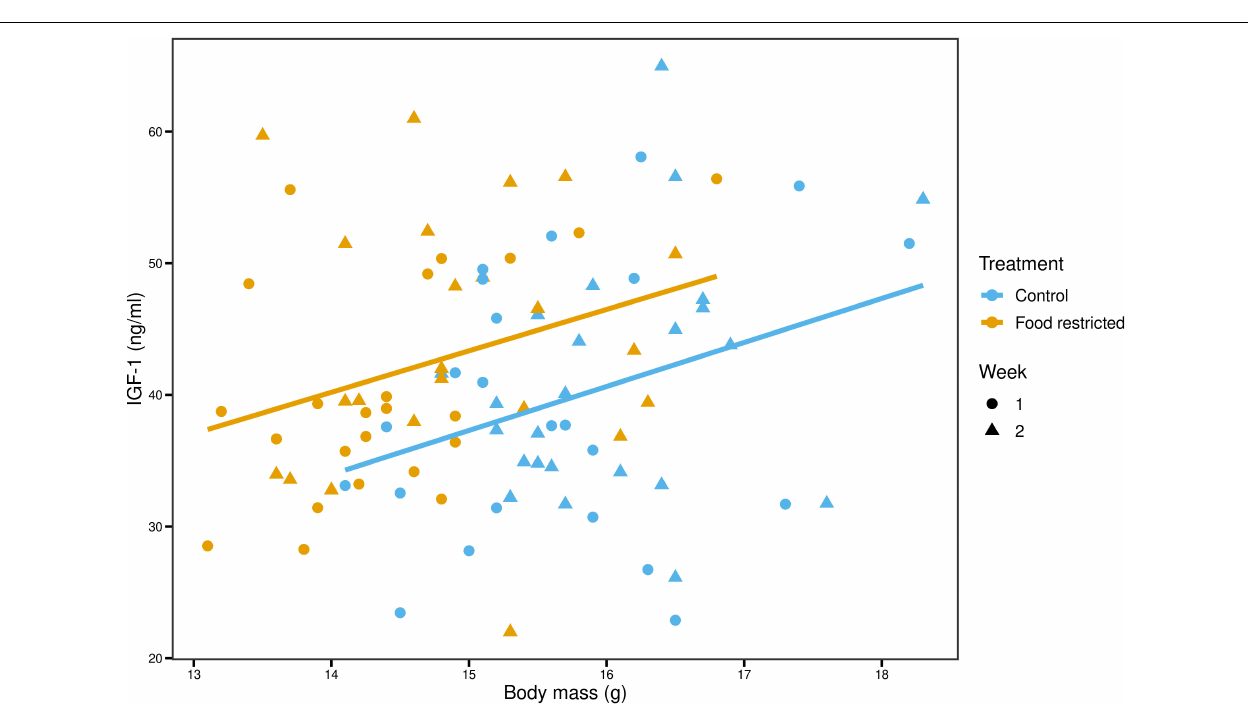
Frontiers in Ecology and Evolution |